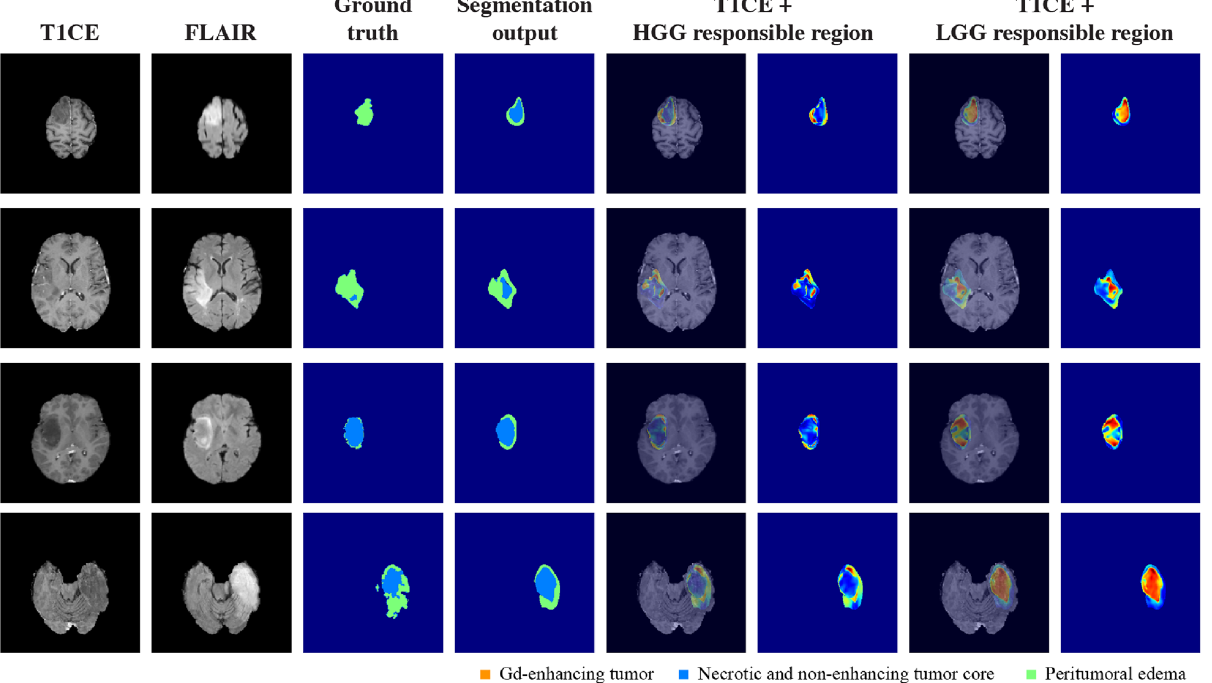
Figure 6. Example results for responsible regions in LGG patients. For patients with LGG, the Gd-enhanced T1 (T1CE) and FLAIR sequences, ground-truth labels, segmentation outputs, HGG responsible regions, and LGG responsible regions are shown. The tumor regions are strongly correlated with the LGG responsible regions, particularly in the central area of the tumor. The overlap with the HGG responsible regions is relatively insignificant and peripherally distributed at best. The color map indicates the high-difference values in red and the low-difference values in blue; the values are standardized for each patient.